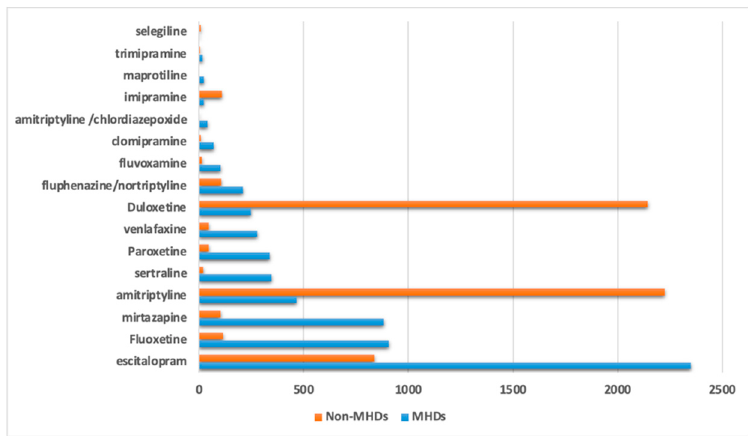
Figure 2. Diagnostic indications for antidepressant prescriptions in the Qatari population for mental health disorders (MHDs) and non-MHDs.